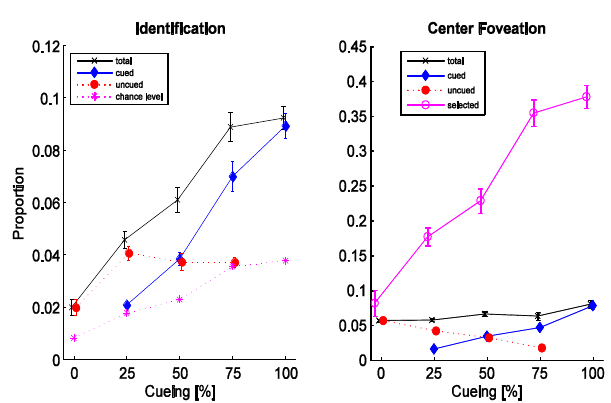
Figure 2. Letter foveation and identification in dependence of the amount of cueing/guidance (0, 25, 50, 75, 100%). Left: Proportion of identified letters. total: cued and uncued (guided/not guided); cued: proportion for cued (marked) letters; uncued: proportion for uncued letters. chance level: proportion of identification responses (see right) divided by the number of letters. Error bars represent standard error of inter- observer performance. Right: Center foveation (1-deg tolerance) for cued and uncued letters. The distribution ‘selected’ is the proportion of identification responses (letter selections using menu) and is shown for comparison